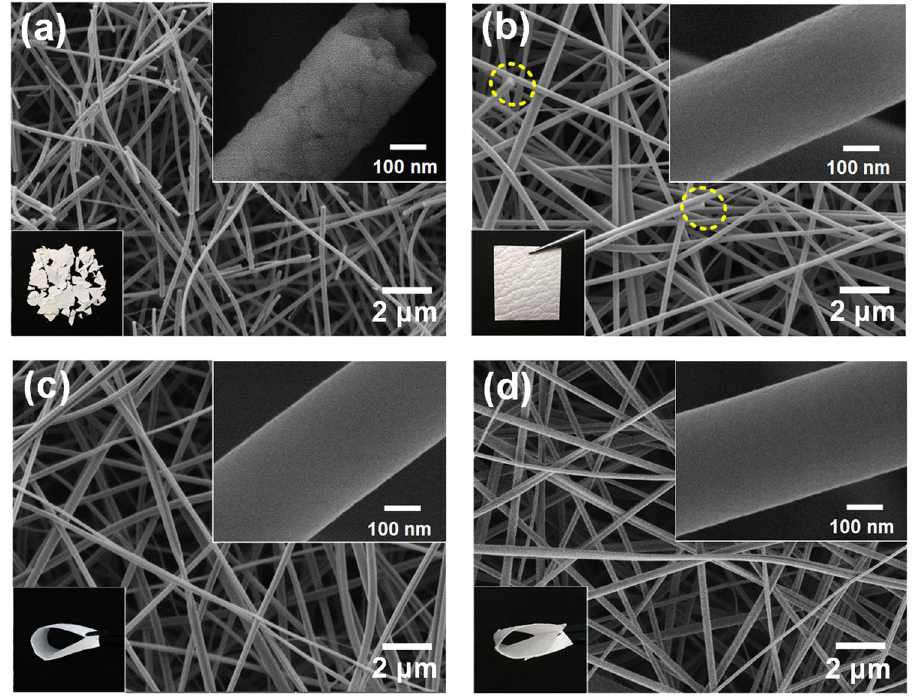
Figure 1. FE - SEM images of ( a ) TiO 2 , ( b ) TZ-5, ( c ) TZ-10, and ( d ) TZ-20 fibrous membranes. The insets are the optical images and magnified images of the corresponding fibrous